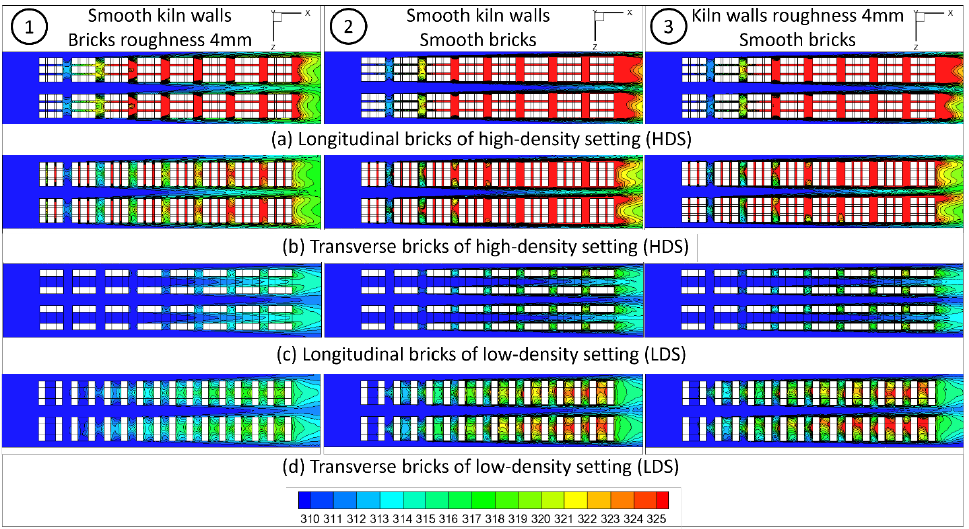
Figure 7. Comparison of the air temperature contours in ( a ) longitudinal bricks for the high-density setting, ( b ) transverse bricks for the high-density setting, ( c ) longitudinal bricks for the low-density setting, and ( d ) transverse bricks for the low-density setting for (1) smooth kiln walls and rough bricks, (2) smooth kiln walls and bricks, and (3) rough kiln walls and smooth bricks.